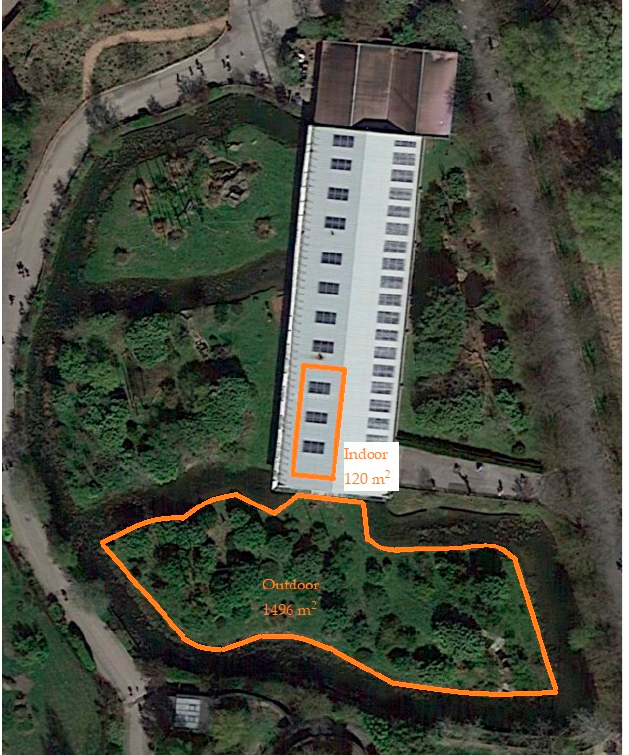
Figure A3. Enclosure plan for Sulawesi crested macaques ( Macaca nigra ) in the Monkey House exhibit. Orange lines signify approximate areas accessed by individual animals with dimensions of total available space. Copyright: Google Earth.